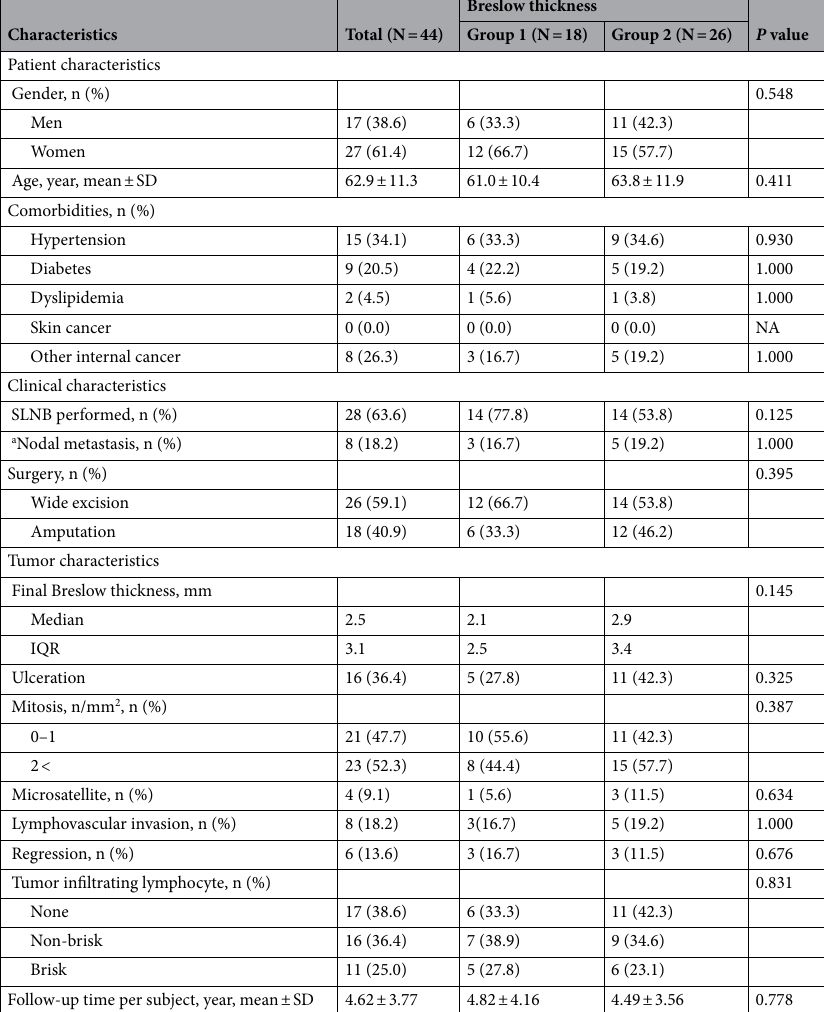
Table 1. Comparison of patient, clinical, and tumor characteristics between the two groups. IQR interquartile range, NA not applicable, SLNB sentinel lymph node biopsy, SD standard deviation. a Clinically occult or detected lymph